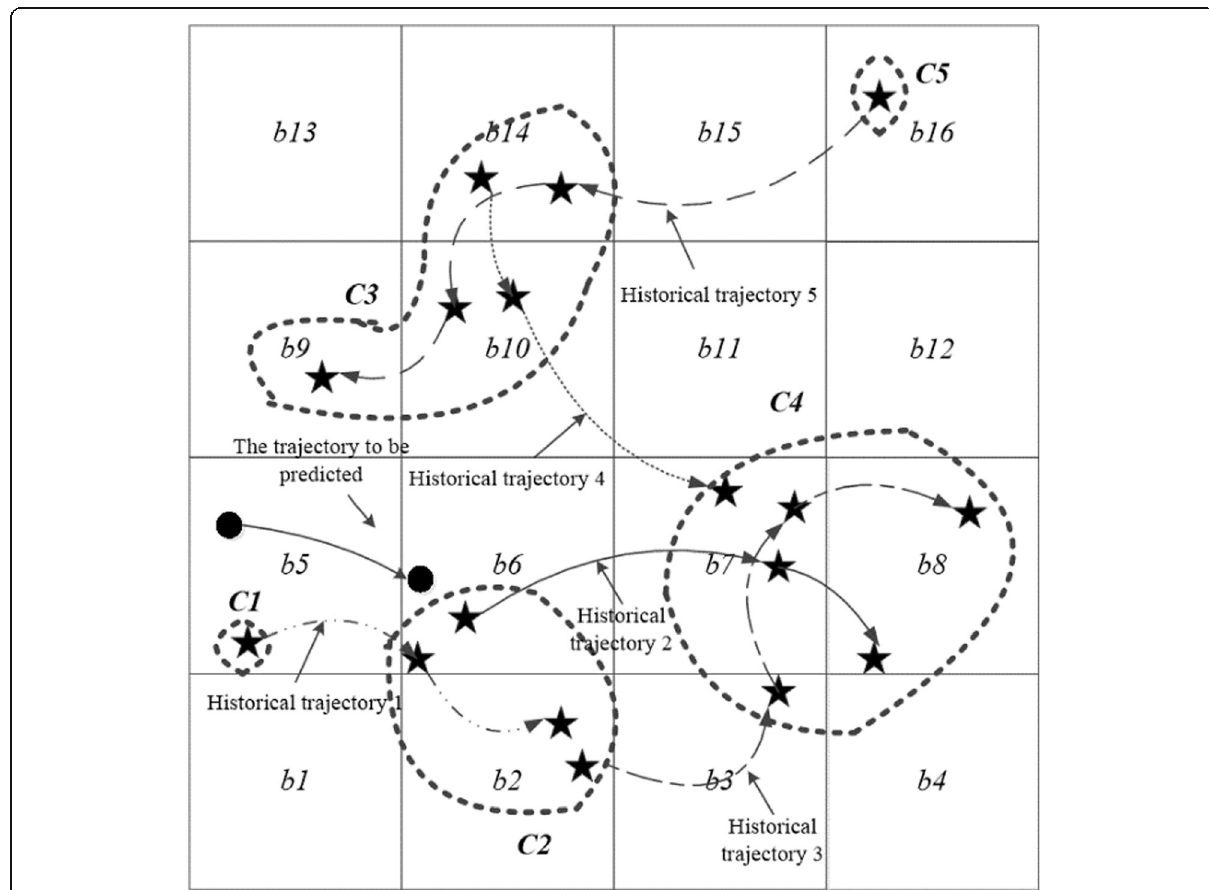
Fig. 3 Example for trajectory prediction method